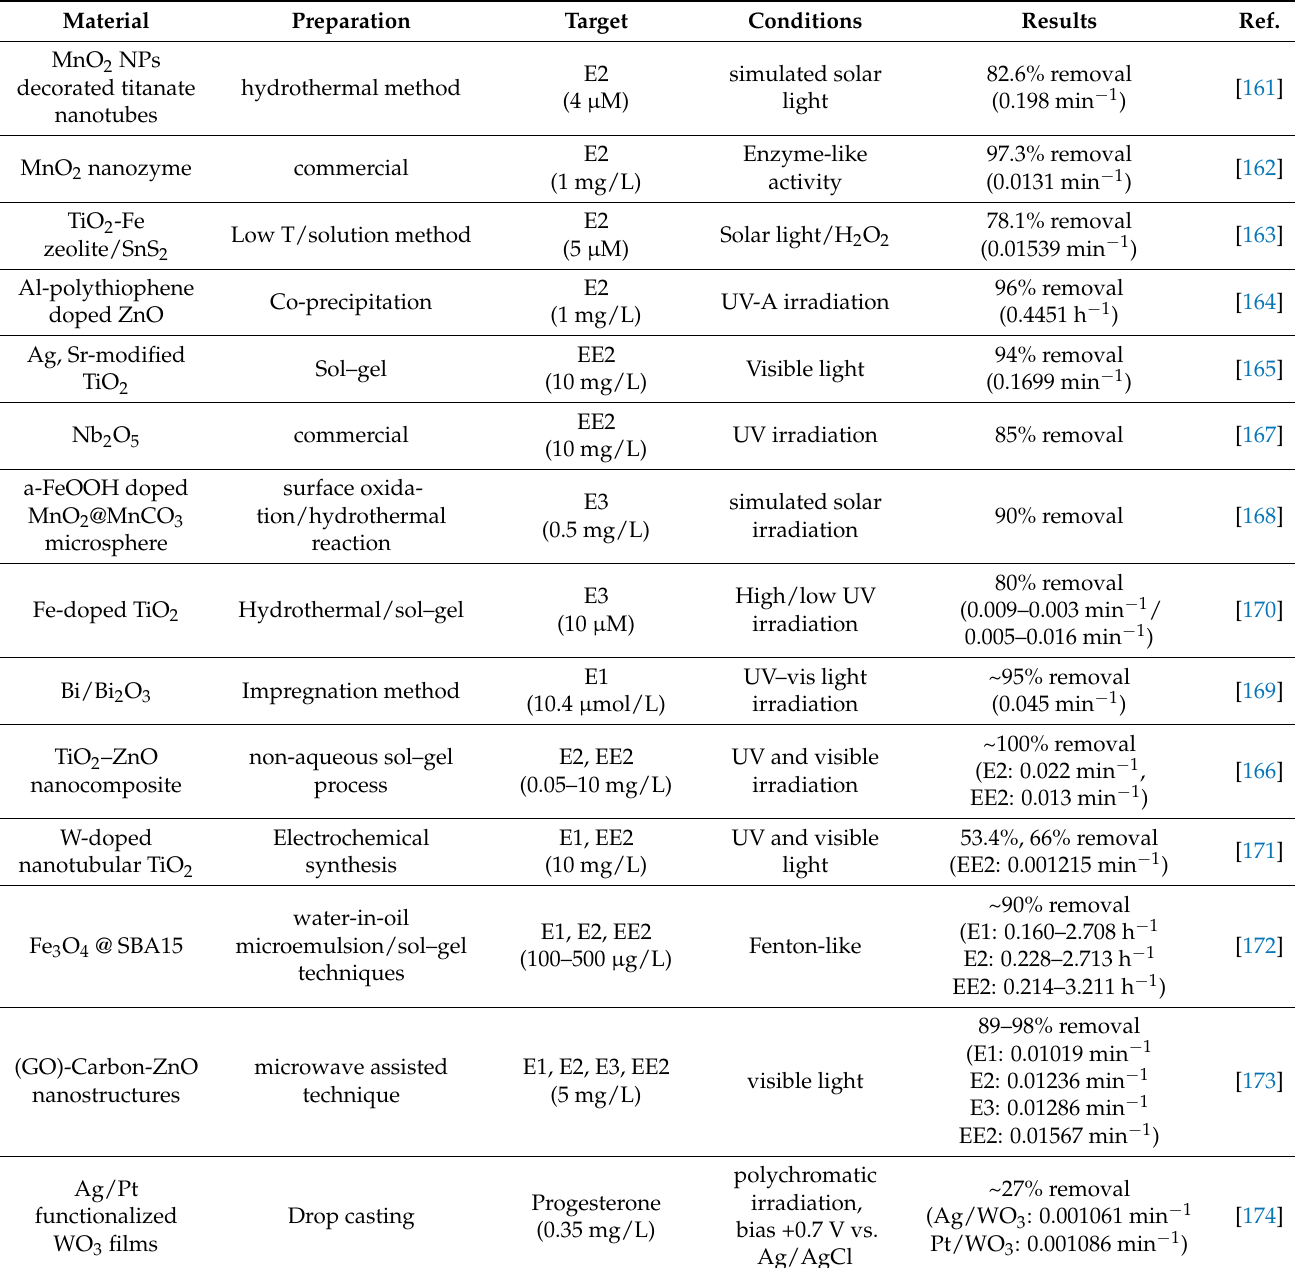
Table 6. Summary of representative metal-oxide-based nanomaterials used for the degradation of steroid